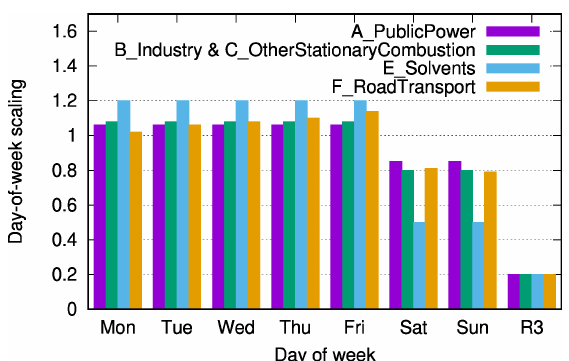
Figure 1. Day-of-week coefficients for the affected sectors. R3 is the value forced for national holidays for the R3